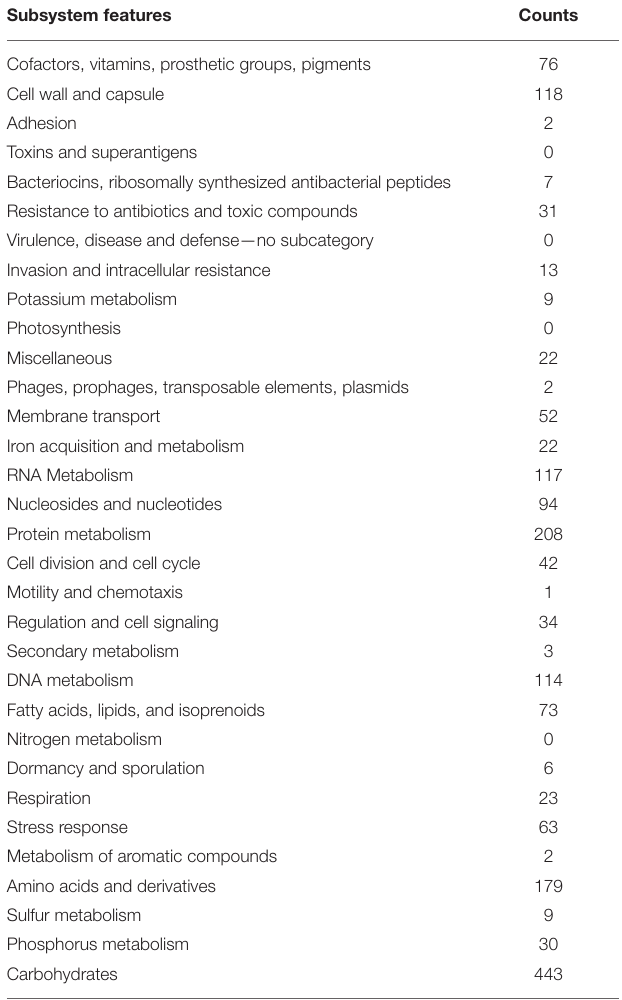
TABLE 4 | Genome Statistics of Enterococcus mundtii QAUEM2808 (Obtained from RAST server). Genome